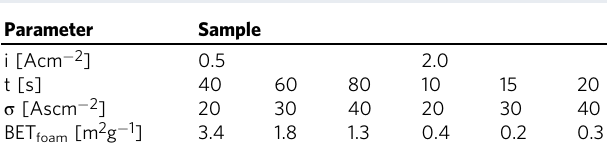
Table 1 Speci fi c surface areas of the porous foam electrodes calculated by BET